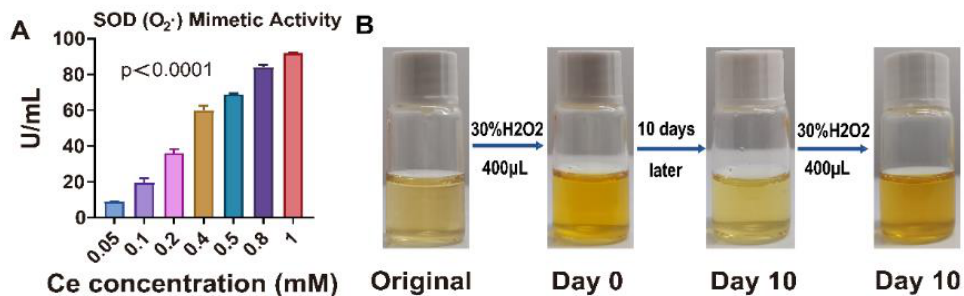
Figure 3. Superoxide dismutase (SOD)- and catalase (CAT)-hybrid-mimetic enzyme activities of CeO 2 @BSA NPs in vitro. ( A ) Statistical graphs of SOD-mimetic enzyme activity of CeO 2 @BSA NPs. ( B ) The digital images showed the coloration of CeO 2 @BSA NP solutions moments after the addition of H 2 O 2 . Ce 3+ redox state is peculiar to colorless ions and the coloration is peculiar to the Ce 4+ redox state. A change in color indicates a change in Ce 4+ /Ce 3+ . H 2 O 2 : hydrogen peroxide. The data are expressed as mean ± SEM of three independent replicates.